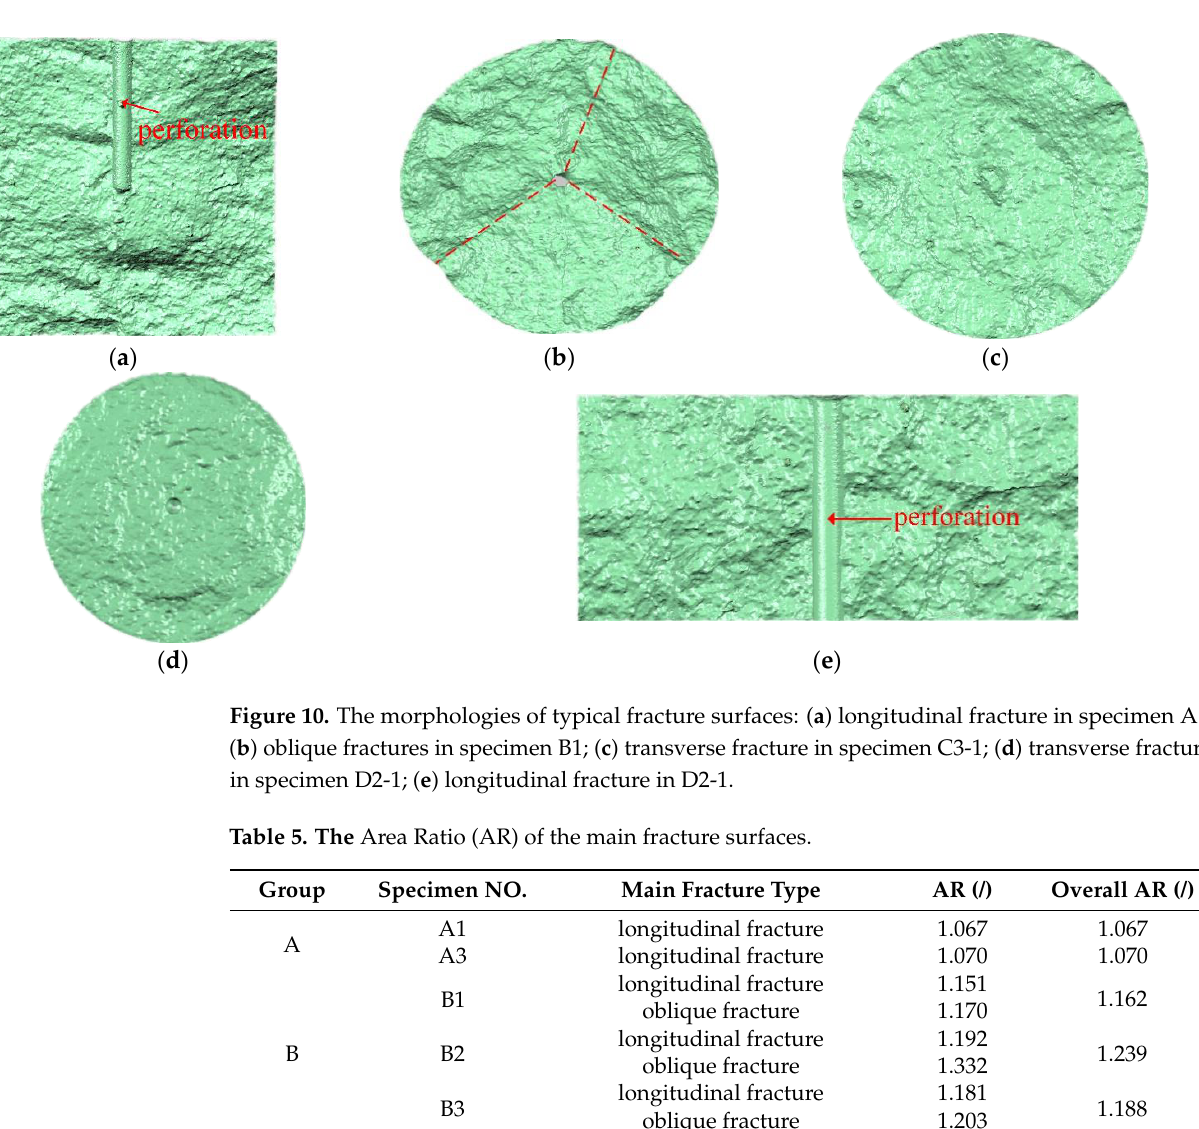
Table 5. The Area Ratio (AR) of the main fracture surfaces. Group Specimen NO.